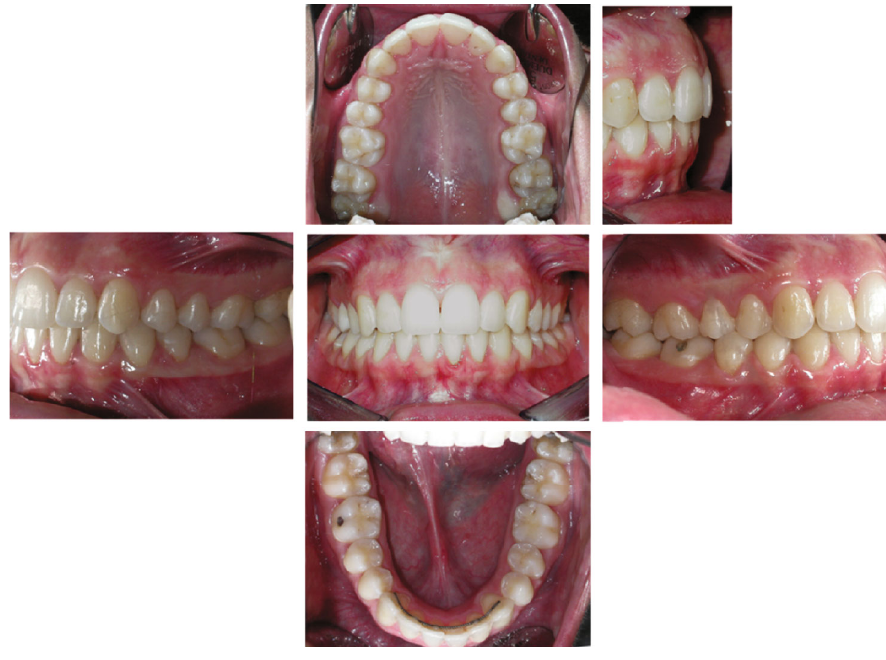
Figure 16: 5-year follow-up intraoral photographs.